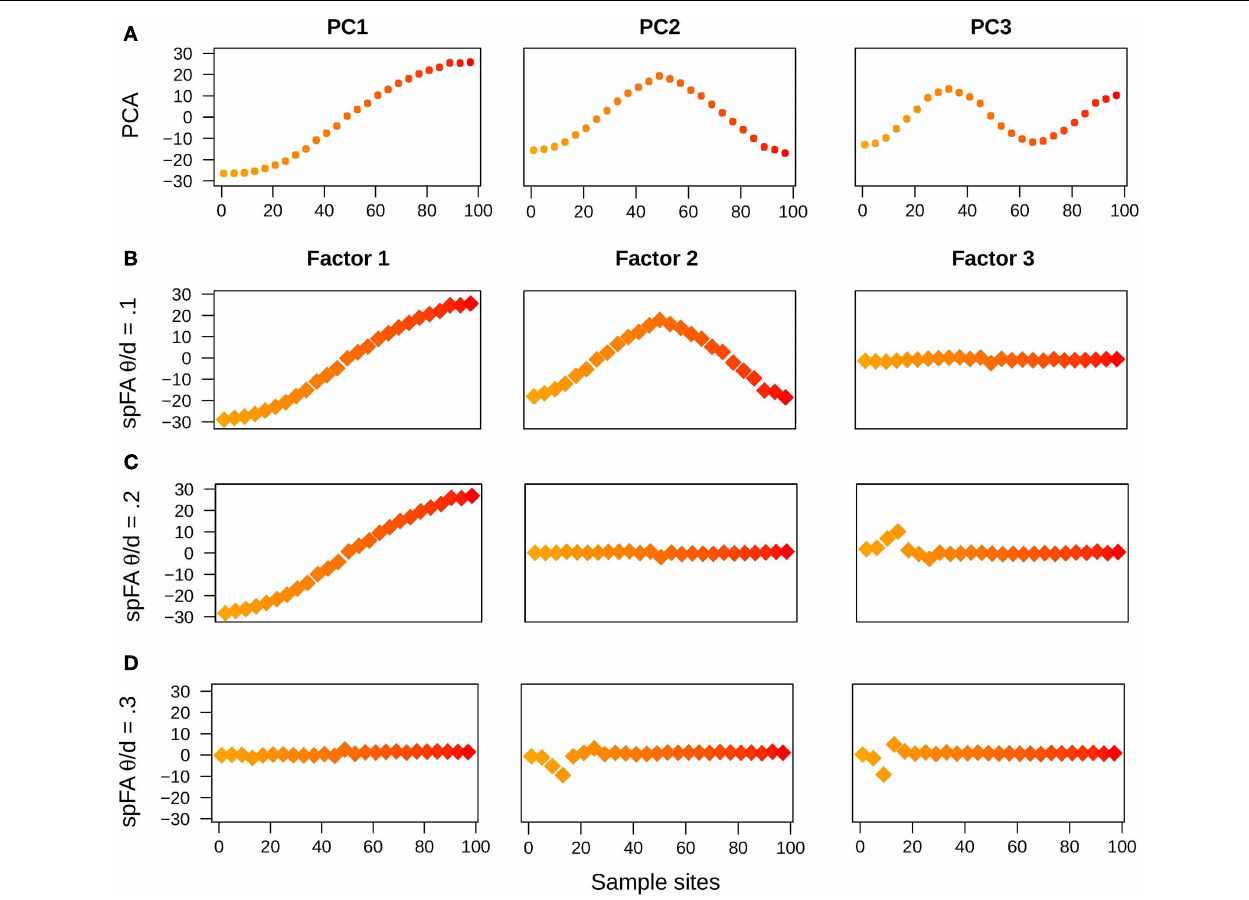
FIGURE 2 | PC and spFA factor maps for data simulated under an IBD model. (A) PC maps, (B) spFA factor maps for θ/ ¯ d = 0.1, (C) spFA factor maps for θ/ ¯ d = 0.2, (D) spFA factor maps for θ/ ¯ d = 0.3.